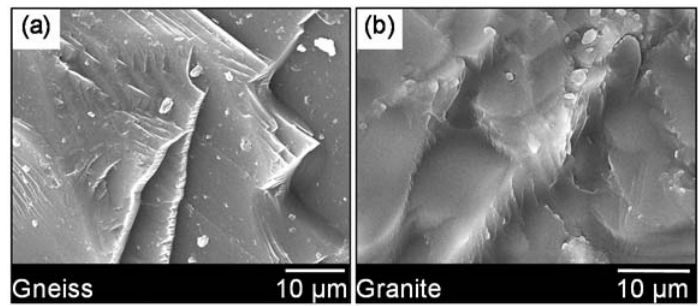
Figure 5. Micro-morphology images of aggregate particles: ( a ) Gneiss [15]; ( b ) Granite.